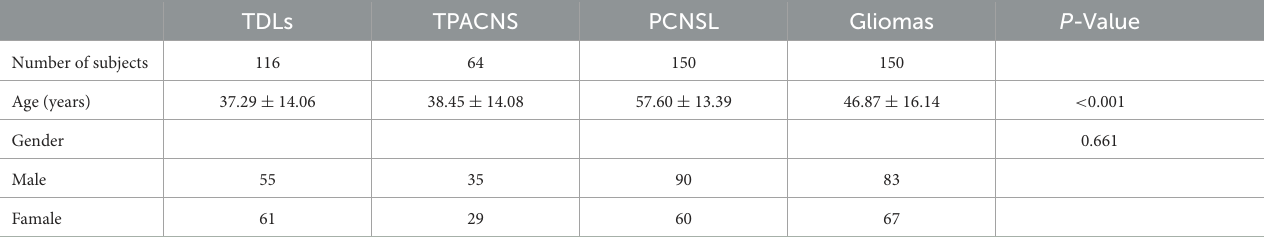
TABLE 1 Clinical characteristics of subjects.